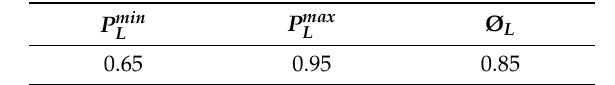
Table 2. Load demand characteristics.